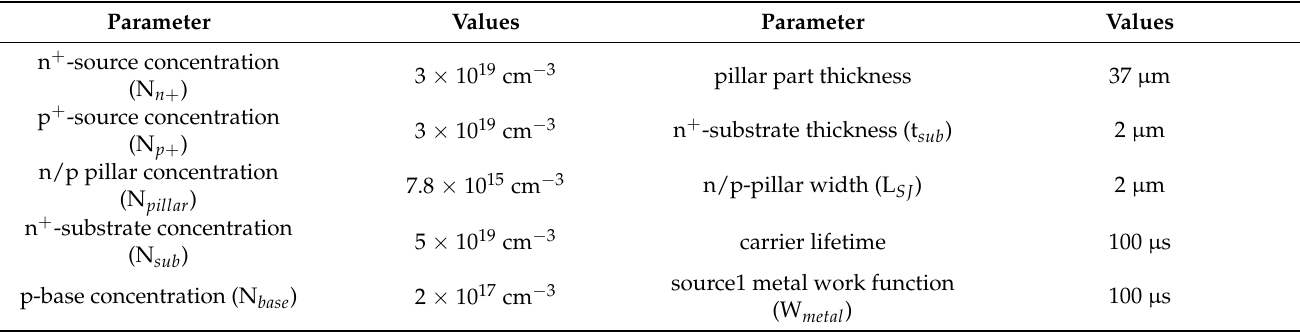
Table 1. Key parameters for SiC/Si SJ with